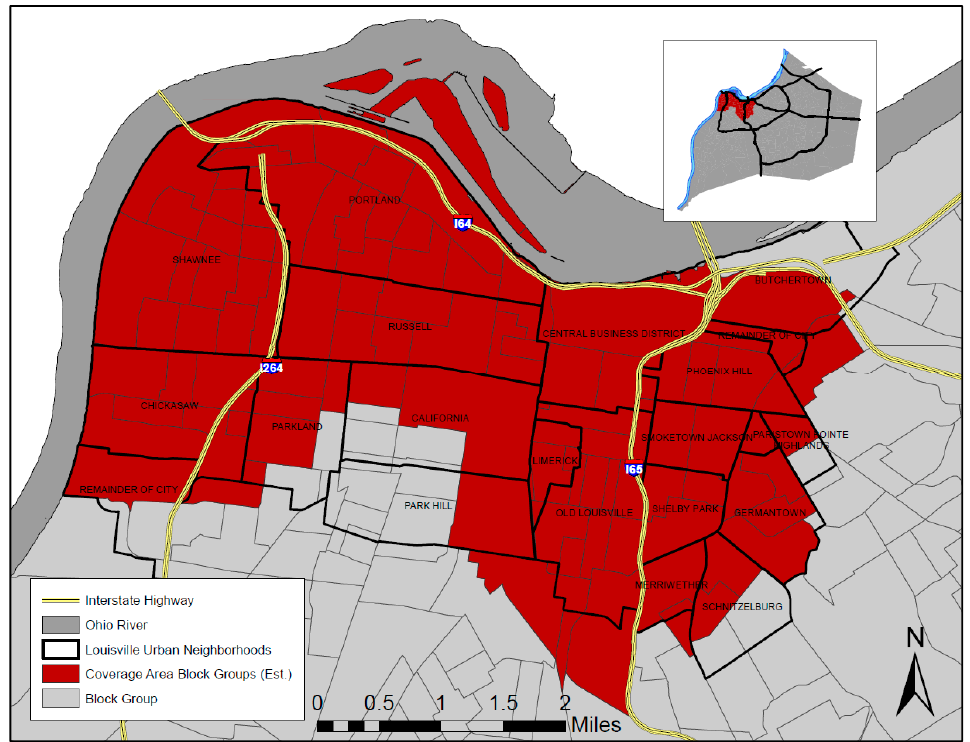
Figure 1. Study area: Estimated coverage area for gunshot detection system in Louisville, KY based on recorded GDT events, June–September, 2017, which includes 82 block groups and portions of 20 urban neighborhoods in West Louisville.